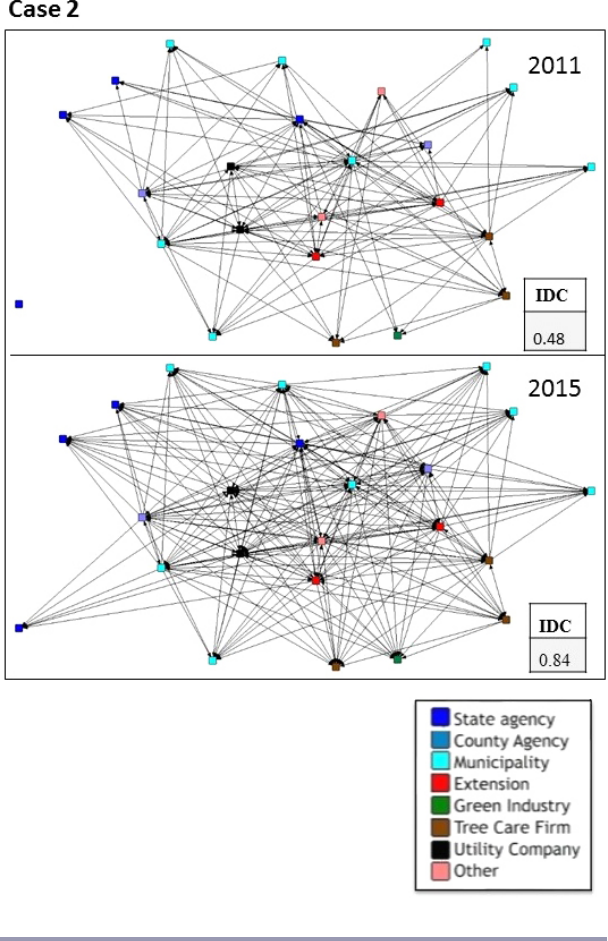
Fig. 2 . Changes in degree centrality (IDC), normalized to group size and network map of emerald ash borer (EAB) task force, Case 2. Note: IDC value refers to mean in-degree